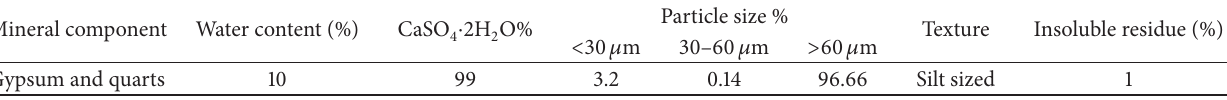
Average of triplicate measurements. Table 5: Some chemical properties of FGDB used to amend alkaline